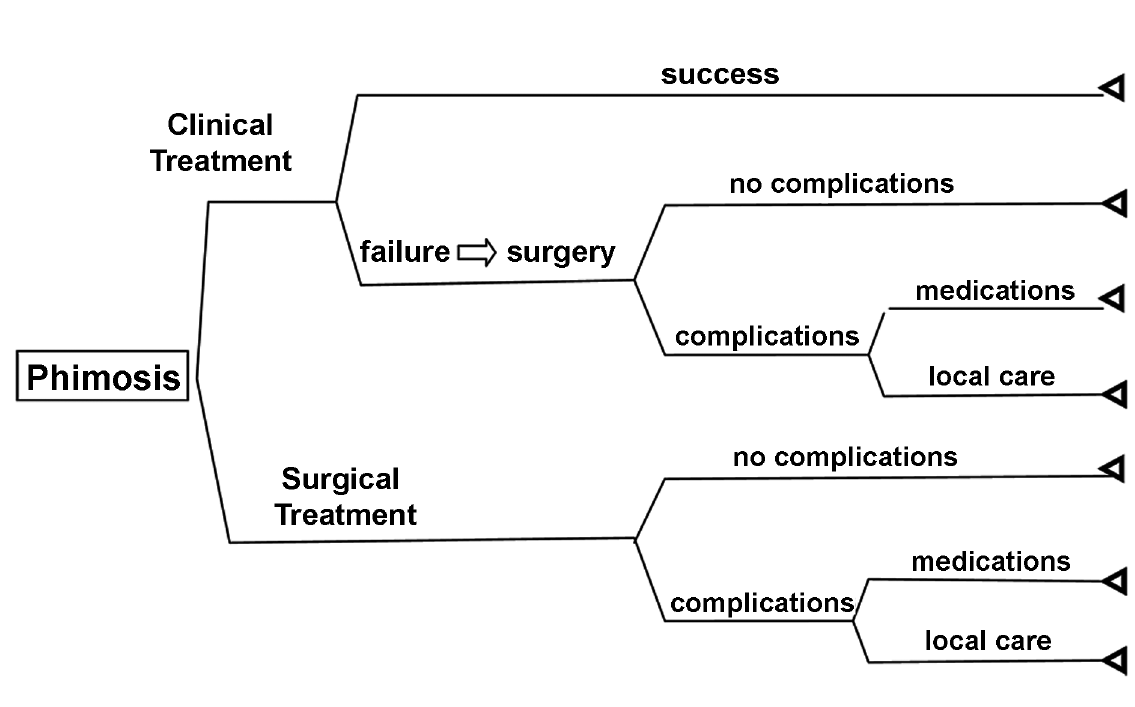
Figure 1 – Flowchart of the pharmacoeconomic study